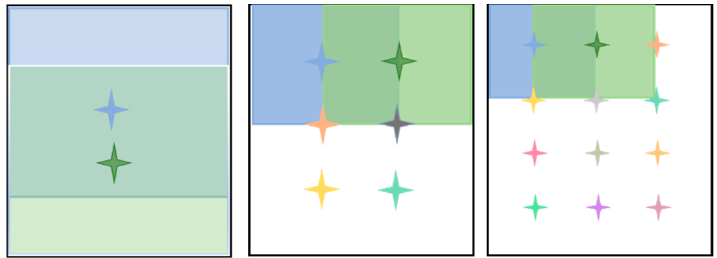
Figure 2. Regional maximum activation of convolution (R-MAC) [25]. The squares of different colors represent the different divided regions, and the dots of different colors represent the center of each region.